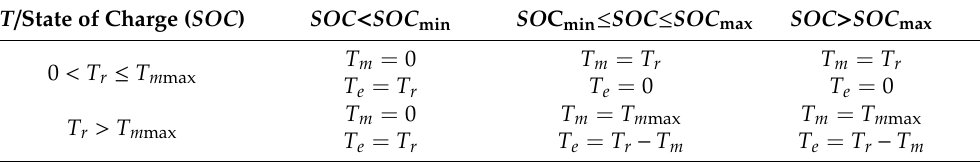
Table 2. Control logic rules based on determining rules *.